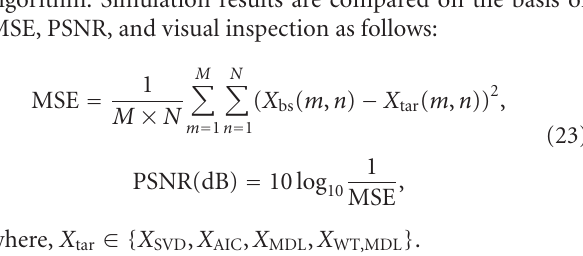
Figure 6: Physical elements of experimental setup at Microwave Engineering Laboratory, College of Signals, NUST. The range resolution Δ R